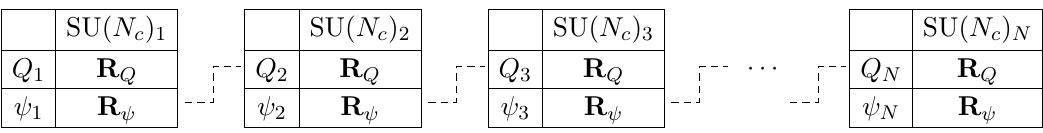
Table 2 . The structure of connected modules of strong dynamics in the contact-connection model. The fermions, Q and , transform as the representations of R Q and R of SU( N c ), respectively. The dashed lines show the links between modules via the interactions in eq.